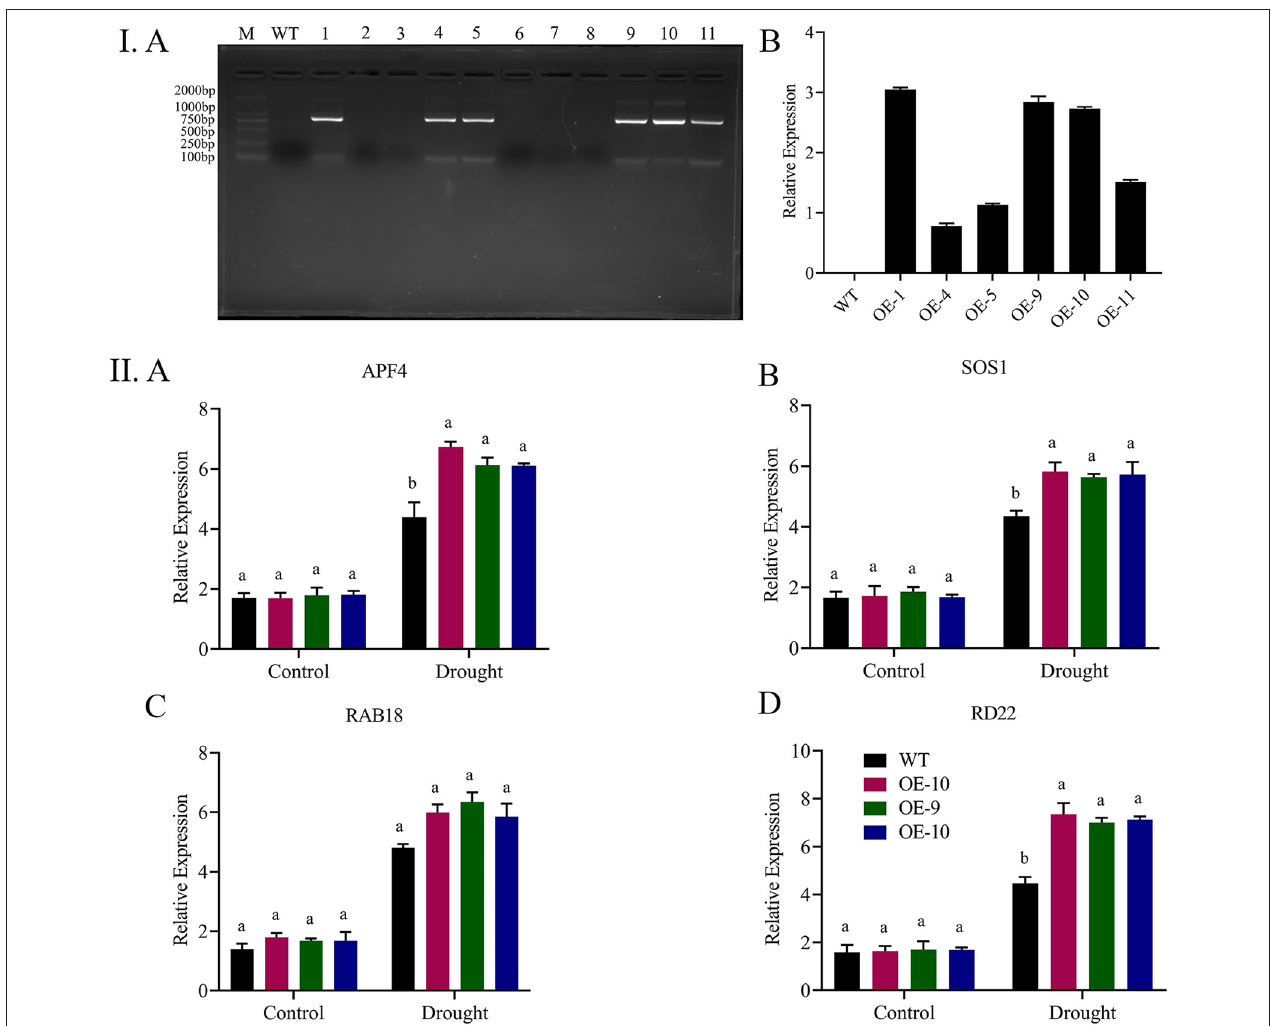
FIGURE 8 | Expression analysis of Gh_A06G1257 by RT-qPCR. (I) A The 771 bp CDS sequence transformation to T2 generation was checked using polymerase chain reaction (PCR), 1–11 overexpressed lines, WT, wild type. B RT-qPCR was used to examine the transcript levels of the Gh A06G1257 (ALDH) of T2 overexpressed lines in three biological replications. (II) Expression analysis of abiotic stress-responsive genes. A APF4, B SOS1, C RAb18, D RD22 in transgenic lines (OE-1, OE-9, and OE-10) and wild type, Atactin2 gene used as an internal reference, and each experiment was done three times. CDS, coding sequence; RTqPCR, Real time quantitative polymerase chain